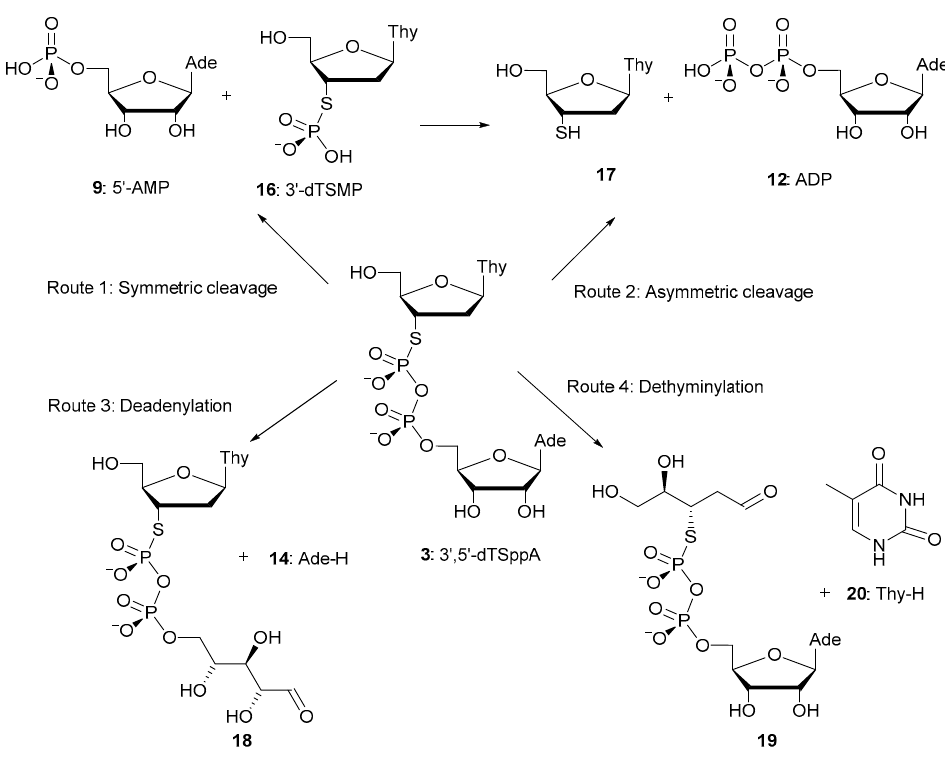
Scheme 2. Potential decomposition routes of dASppA ( 1a ).